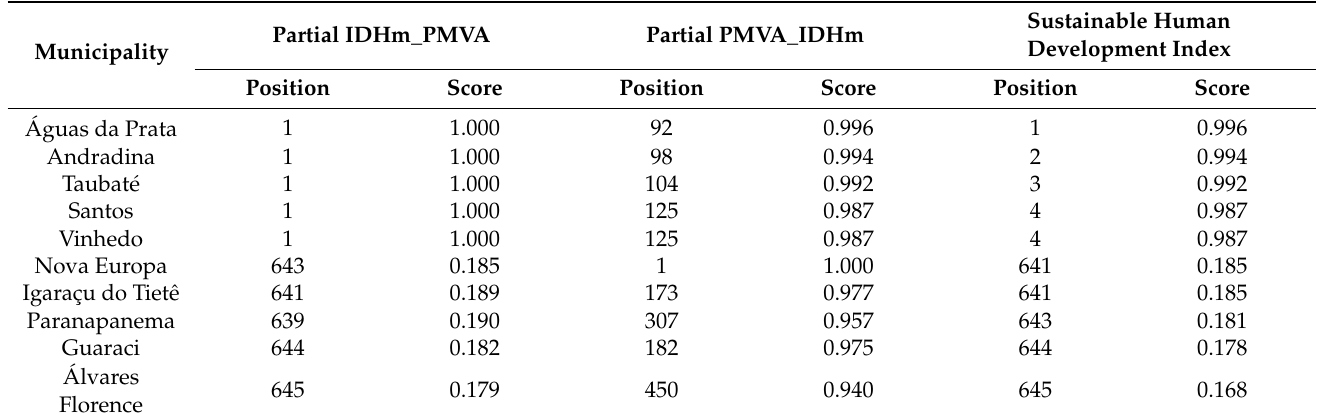
Table 3. First and last places in the partial and final